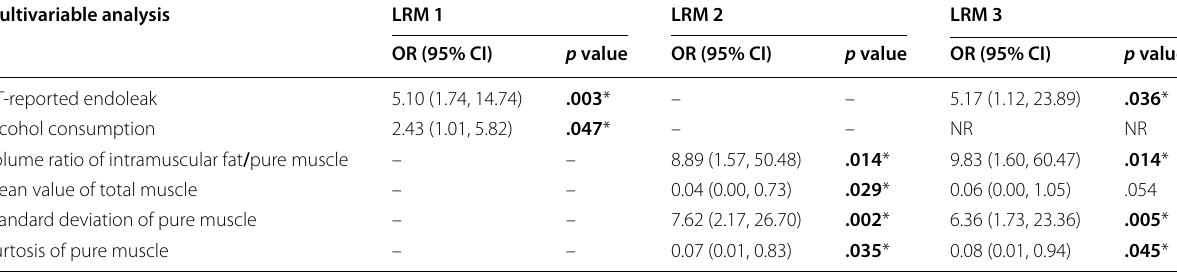
LRM logistic regression model, OR odds ratio, CI confidence interval, NR not reported * p values in bold highlight the figures less than